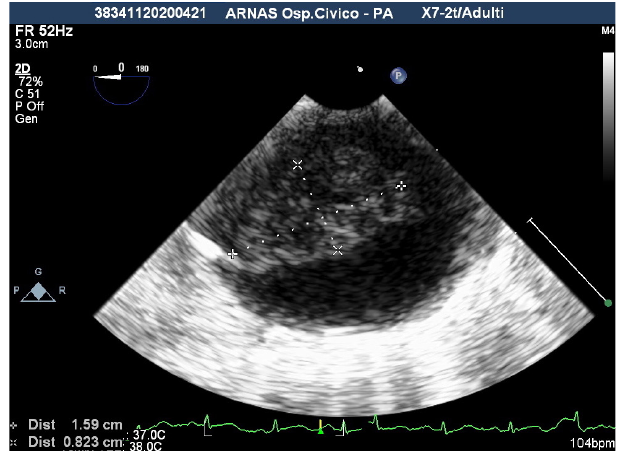
Fig. 1C – Transesophageal echocardiography showing aortic mural thrombus as